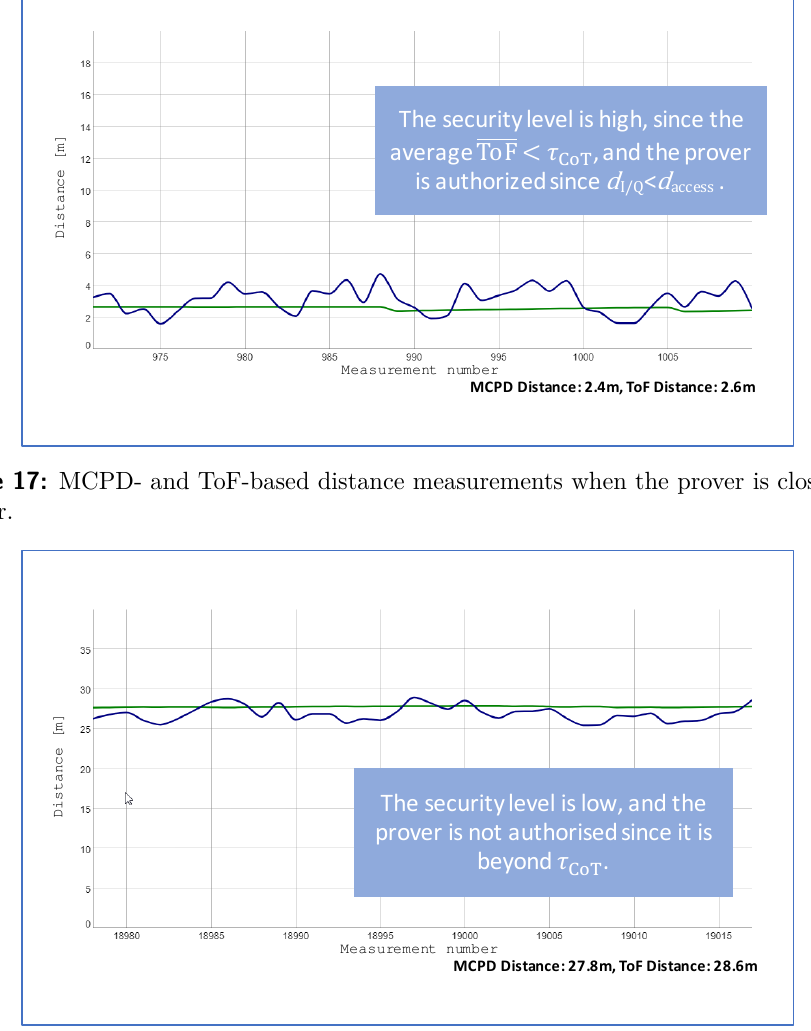
Figure 18: MCPD- and ToF-based distance measurements when the prover is far away from the